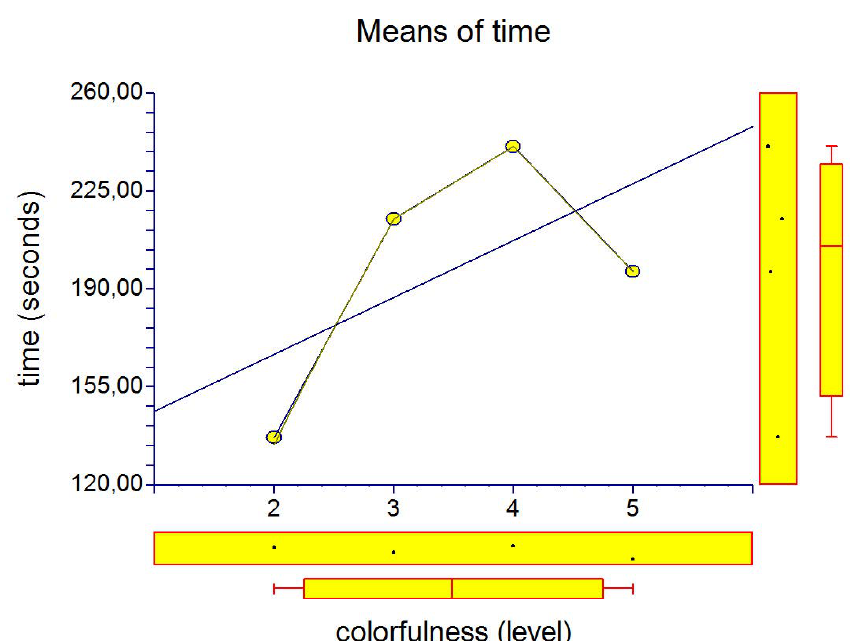
Figure 10. Exp. no. 2—Box Plot.